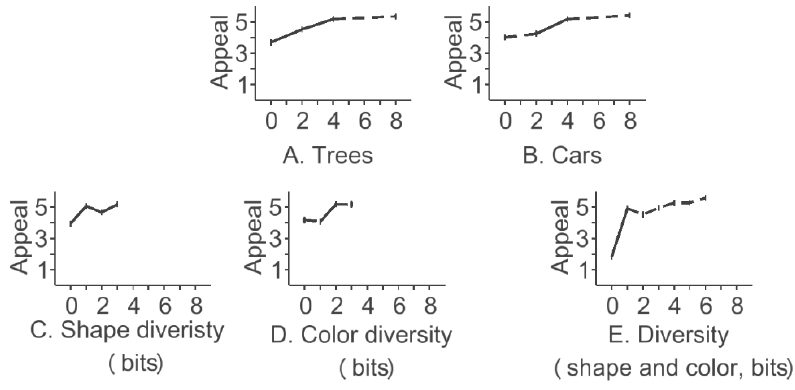
Figure 4. Results for the Little Boxes experiment. Solid lines indicate contrasts that achieved the individual “ p < 0.05” level of